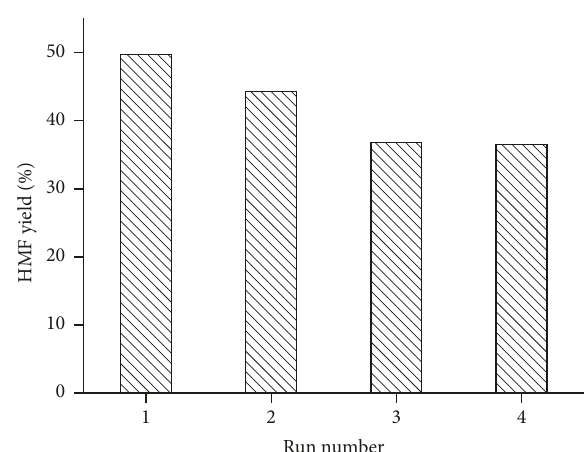
Figure 4: Recyclability study of S-AlMo catalyst for fructose